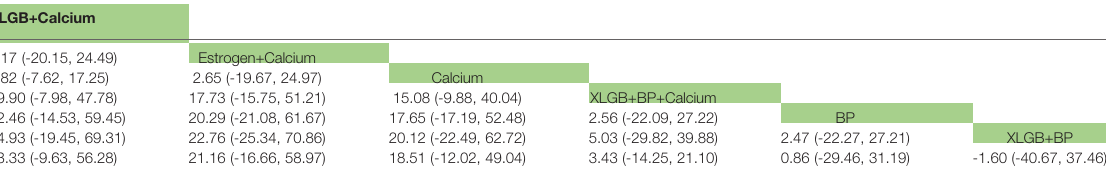
TABLE 10 | Network meta-analysis of BGP.